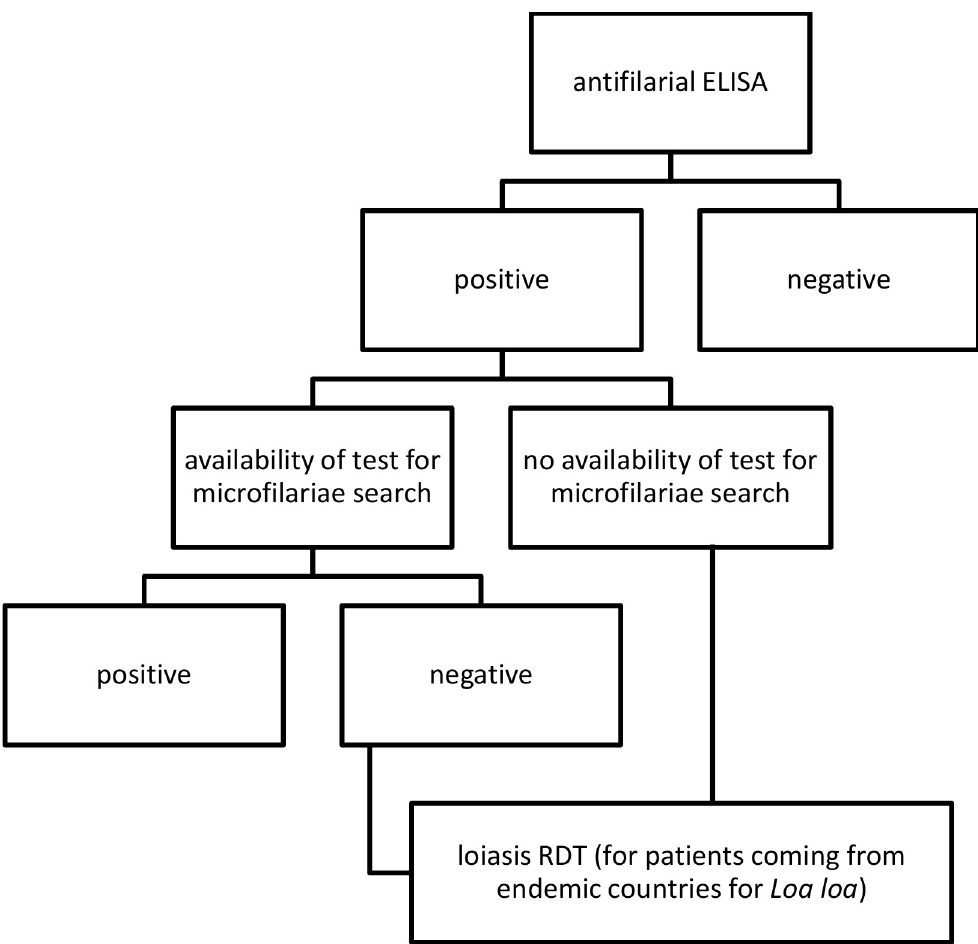
Fig 2. Proposed algorithm for diagnosis of filariasis in non-endemic